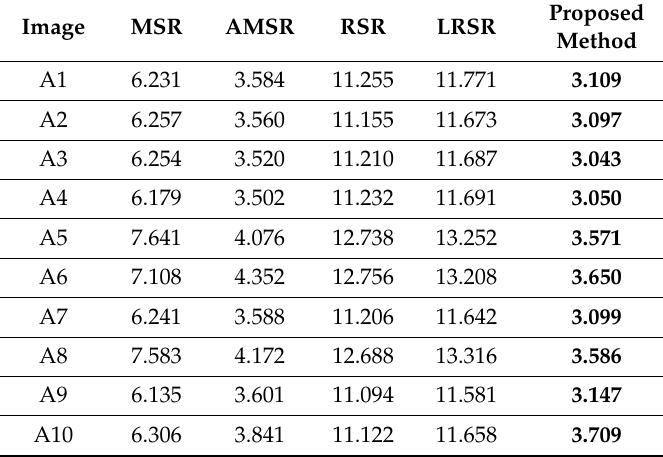
Table 2. Processing-time per pixel comparisons (unit: